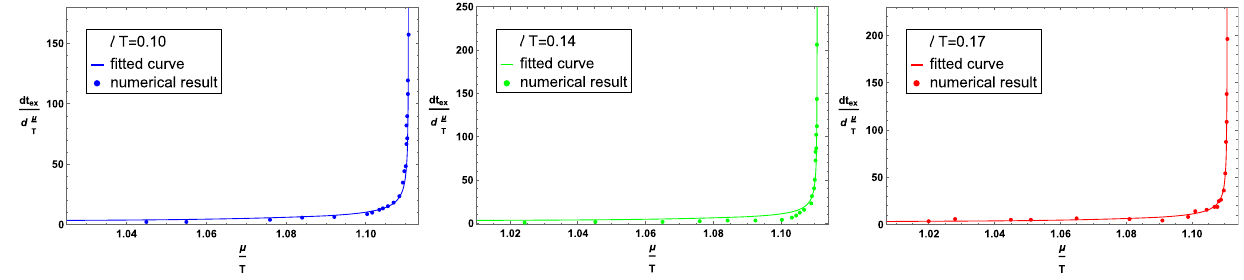
Fig. 8 dt ex as a function of μ . Left: We fixed the values of interquark and lT = 0 . 14. The Green curve is the same function fitted with the T d μ T data with θ = 0 . 529178. Right: We fixed the values of interquark dis- distance l = 0 . 27,thetransitiontime k = 0 . 3,thetemperature T = 0 . 37 tance l = 1, the transition time k = 0 . 3, the temperature T = 0 . 17 and − μ ) − θ , fitted with √ and lT = 0 . 10. The blue curve is the function, ( π T 2 2 lT = 0 . 17. The red curve is the same function fitted with the data with the data with θ = 0 . 515667. Middle: We fixed the values of interquark θ = 0 . distance l = 0 . 45,thetransitiontime k = 0 . 3,thetemperature T = 0 . 31